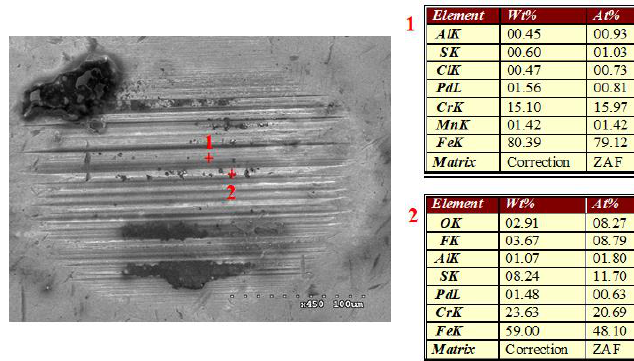
Figure 13. The SEM images of the stainless-steel ball with the test conditions: Amorphous Pd at 200 °C and sliding speed of 7 mm/s.